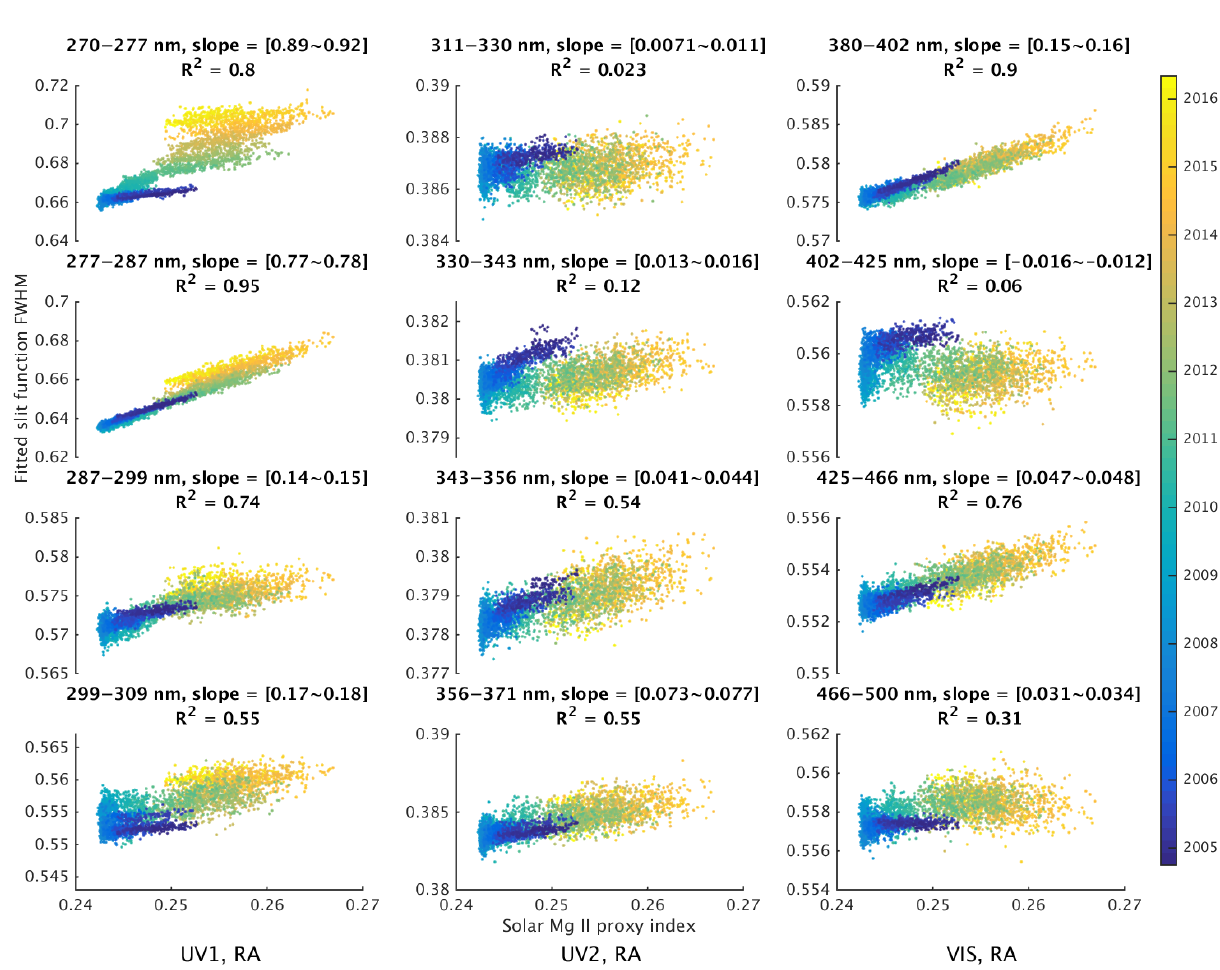
Figure 6. The same as Fig. 5 but for the RA rows. The ranges of vertical axes are the same as Fig. 5 as well for easier